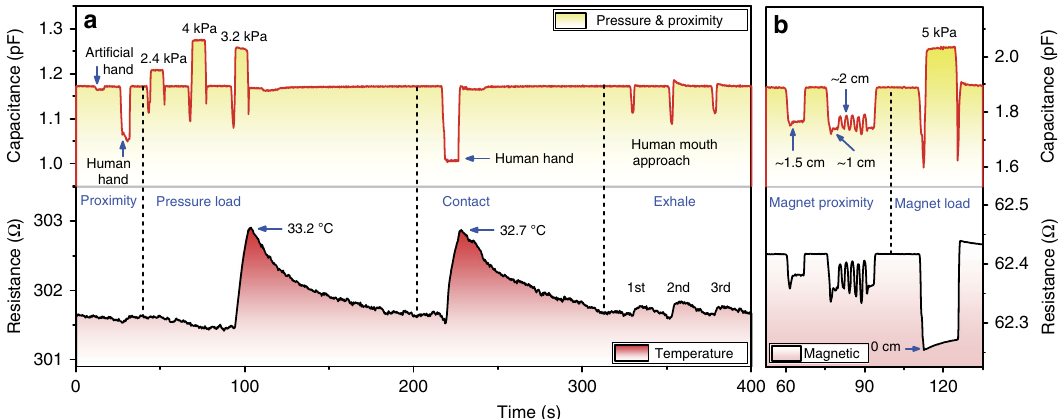
Fig. 5 Simultaneous multiple-stimuli sensing performances. a Real-time simultaneous sensing of temperature, pressure, and proximity stimuli. Signals in recording: Proximity — arti fi cial/human hand approaches the SCMN with a distance of about 1 cm; Pressure — loading bottles on the SCMN with pressures of 2.4 kPa (empty), 4 kPa ( fi lled with water), and 3.2 kPa ( fi lled with hot water) consecutively; Contact — human hand on the SCMN; and Exhale — human breaths toward the SCMN for three times (Details are described in Supplementary Movie 4). b Real-time simultaneous sensing of magnetic fi eld, pressure, and proximity stimuli. The detailed procedures of a permanent magnet put near or loaded on the SCMN: the magnet approaches the SCMN with a distance of about 1.5 cm; the proximity distances change between 1 cm and 2 cm alternatively; the magnet loaded on the SCMN corresponding to a pressure of 5 kPa (see Supplementary Movie